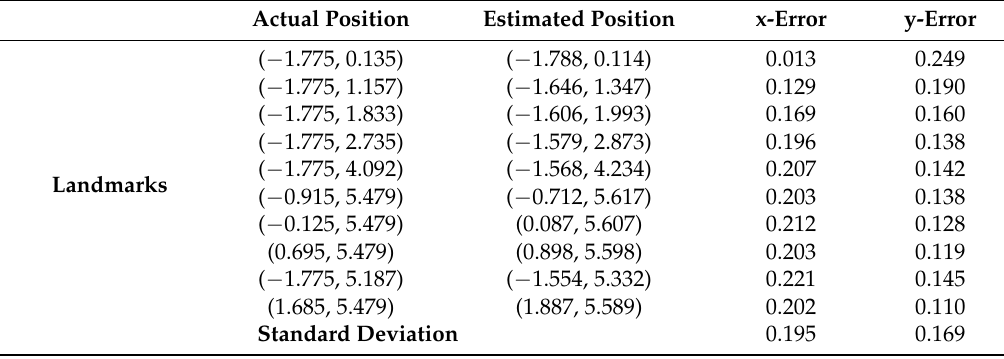
Table 4. Localization results of landmarks. X-error: the error of the landmarks’ positioning in the x -axis direction. Y-error: the error of the landmarks’ positioning in the y -axis